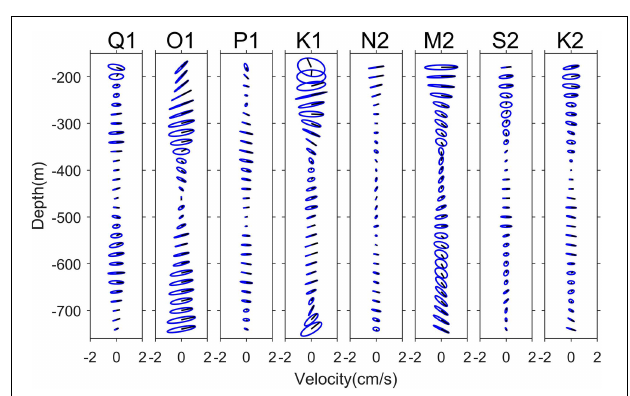
FIGURE 5 | Vertical distribution of baroclinic tidal ellipses for eight main tide